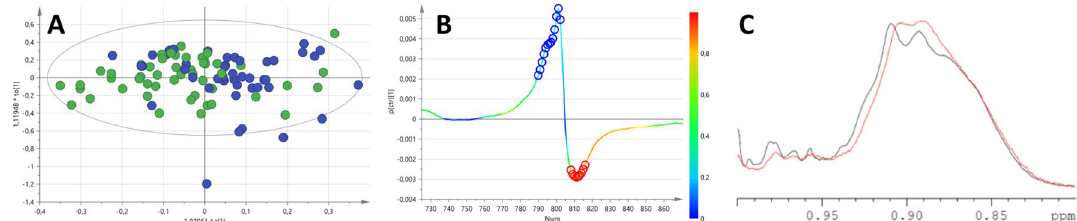
Figure 2. OPLS-DA models differentiating between men and women ( A ). The s-plot ( B ) shows that women lipid peaks tend to shift to high fields (blue circles), as also shown in the example of the methyl lipid peaks ( C ; red represent men, black represent women).